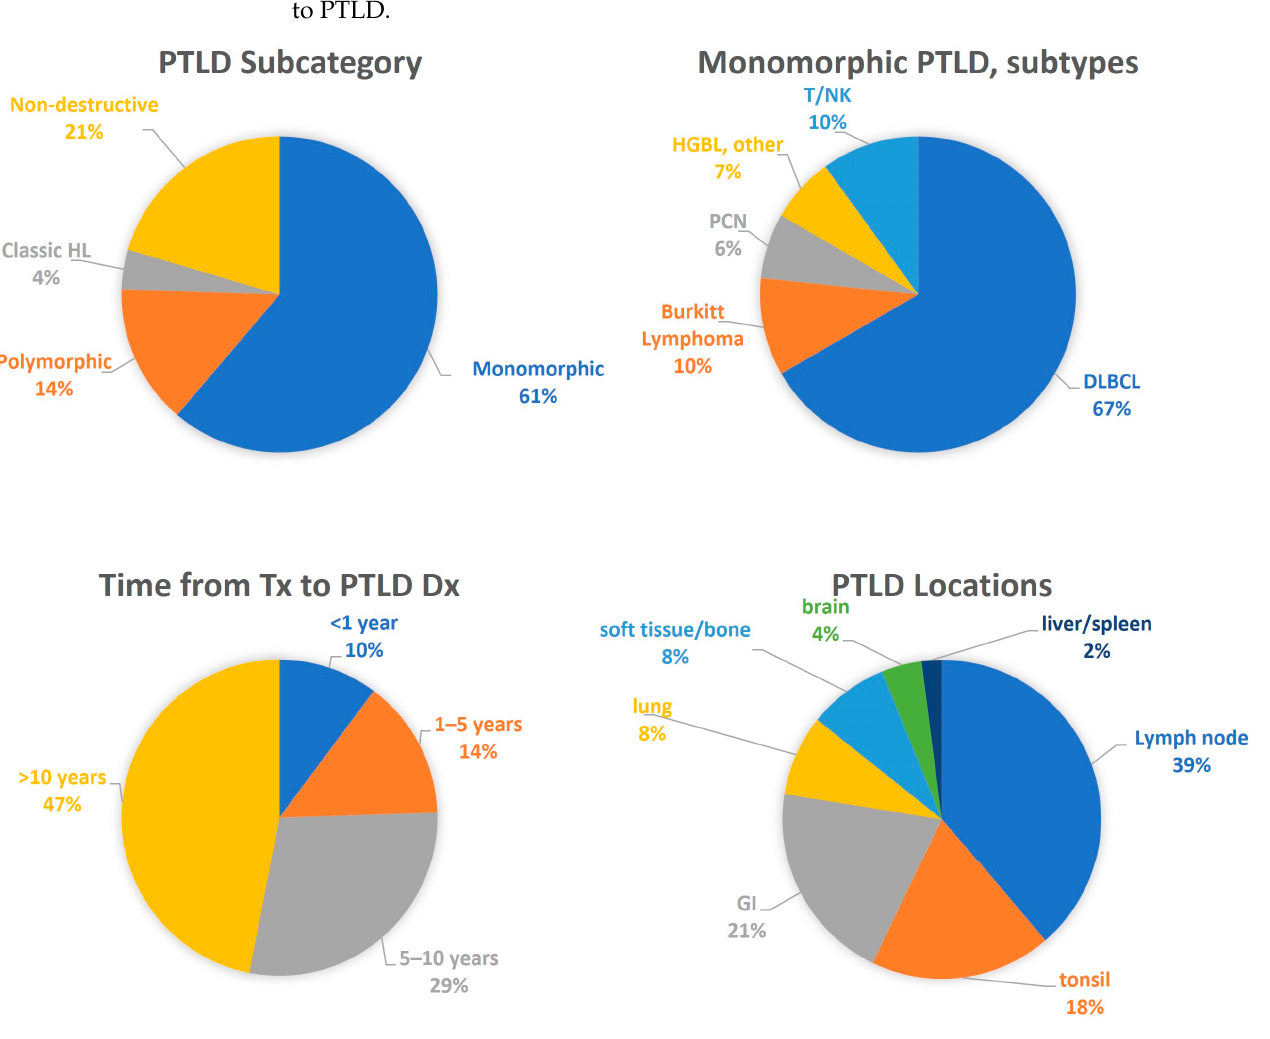
trointestinal tract (21%), lung (8%), soft tissue/bone (8%), brain (4%), and liver/spleen (2%). All 4 cases of plasmacytic lesions (plasmacytic hyperplasia (2) and plasma cell neoplasm (2)) were in Hispanic/Latino patients.